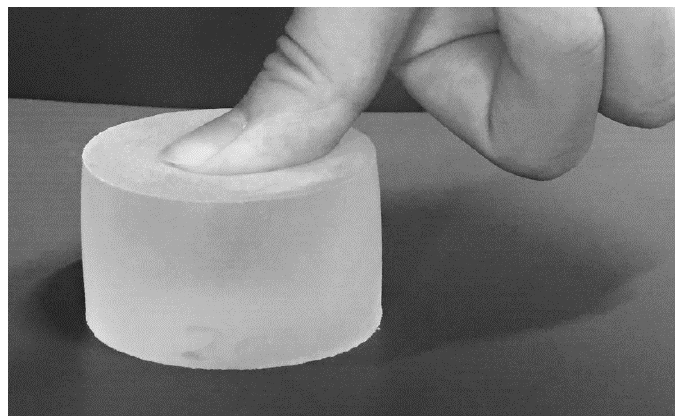
Figure 3. Example of depressing the centers of one test piece.